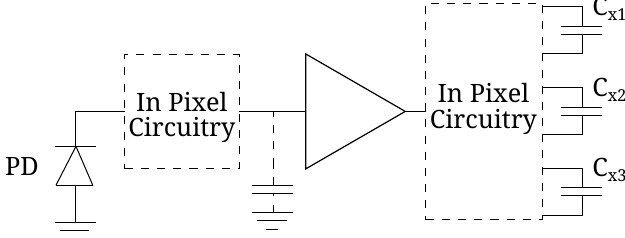
Figure 4. Schematic of a voltage mode pixel for 1B techniques.